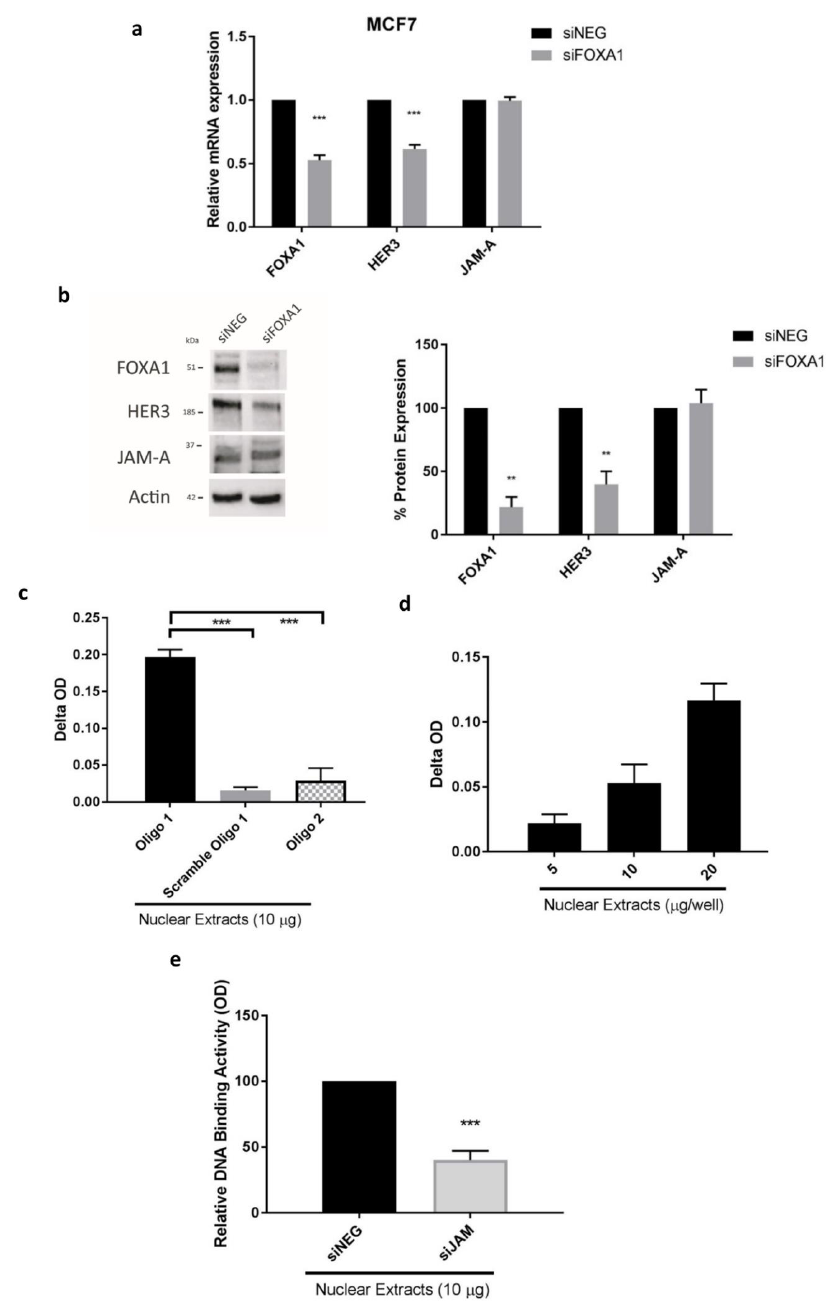
Figure 4. FOXA1 is a putative transcription factor controlling the mRNA and protein expression of HER3. RNA and protein from MCF7 cells transfected with 25 nM control siRNA (siNEG) or a pool of siRNA targeting FOXA1 for 72 h were extracted for analysis. ( a ) qRT-PCR revealed that HER3 mRNA expression was reduced after FOXA1 gene silencing, while JAM-A mRNA expression was not affected; ( b ) Representative western blot image and densitometric analysis for HER3 and JAM-A protein normalized to actin expression after FOXA1 knockdown revealed that HER3 protein expression was affected by FOXA1 knockdown, while it had no effect on JAM-A expression. Nuclear proteins of untreated MCF7 cells were extracted and subjected to protein-DNA binding assays using specific oligonucleotides that represented putative FOXA1 binding sites in the HER3 gene promoter. ( c ) Results of the colorimetric measurement of the reactions (Binding Activity = delta